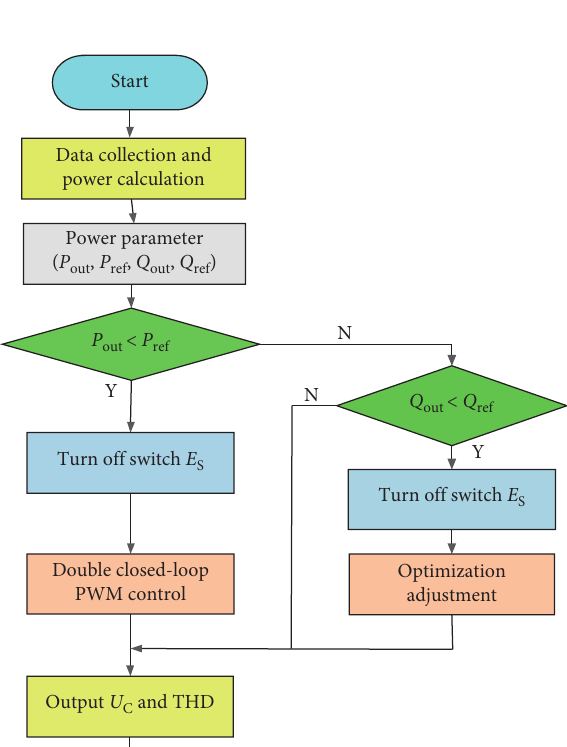
Figure 6: Multimode power regulation control.